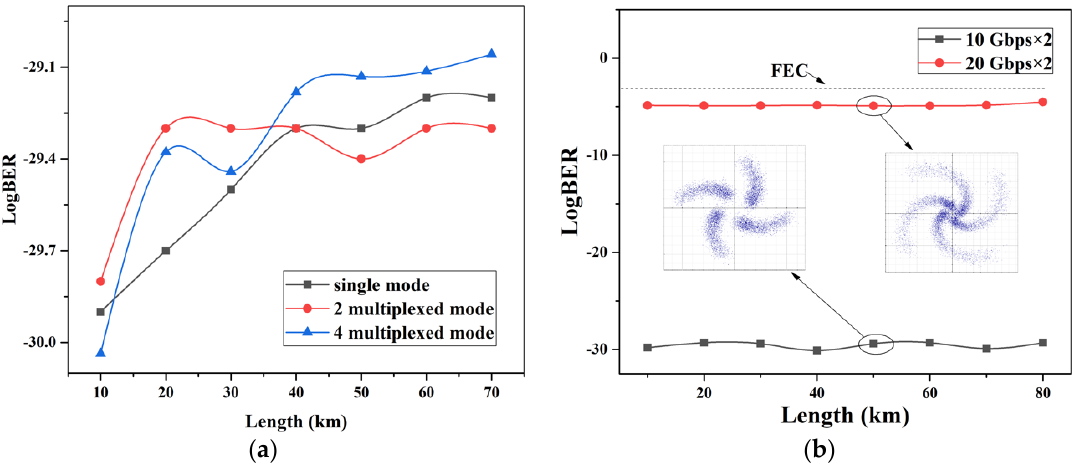
Figure 8. BER curves with ( a ) single OAM mode versus multiplexed OAM modes; ( b ) 10 Gbps versus 20 Gbps single channel data rate in the OAM-DM-WDM-OFDM-PON system upstream link.